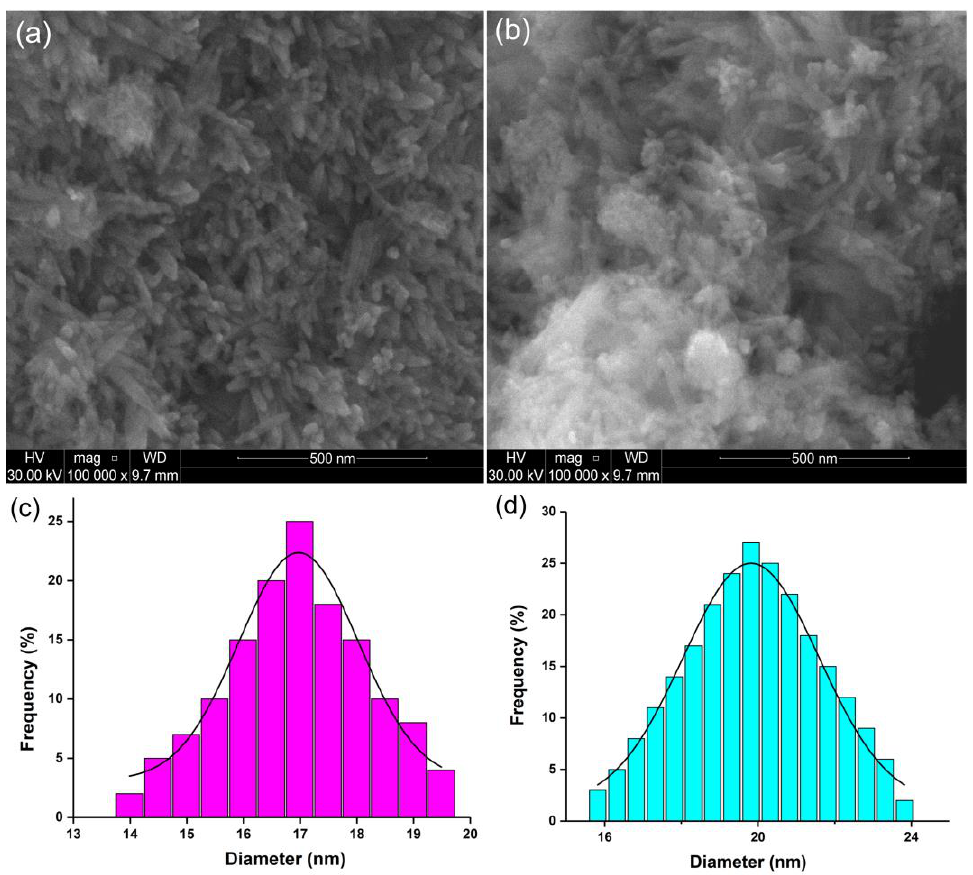
Figure 2. SEM micrograph of AgHA-C ( a ) and AgHA-T ( b ) suspensions. Mean diameters calcu- lated from SEM analysis for AgHA-C ( c ) and AgHA-T ( d )